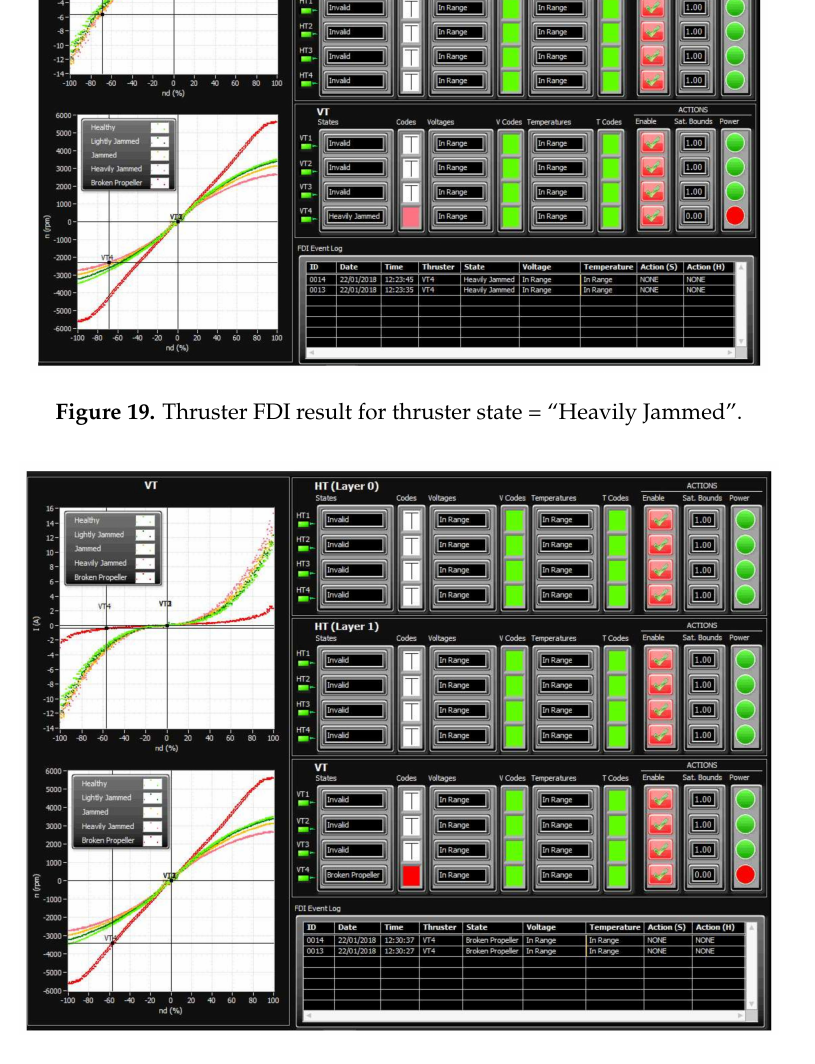
Figure 20. Thruster FDI result for thruster state = “Broken